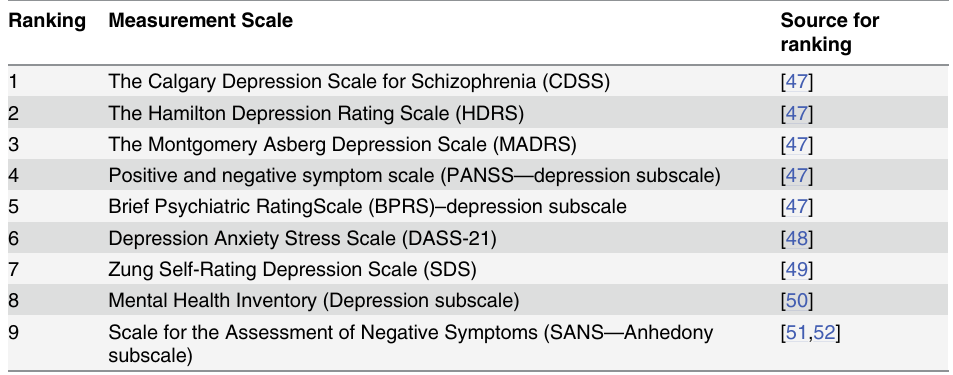
Table 2. Hierarchy of preferred depression measurement